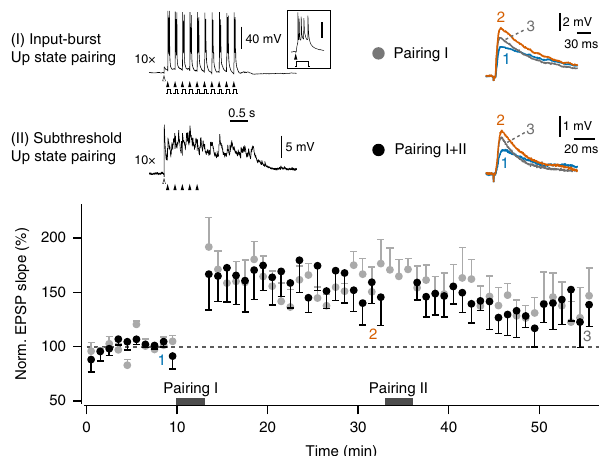
Fig. 2 Pairing subthreshold inputs with Up states does not reverse synaptic potentiation. Pairing synaptic input with spike bursts during Up states induced synaptic potentiation (Pairing I: stimulus trains at 5 Hz, 100 pairings in total; each extracellular stimulation was followed by a depolarizing current step evoking > 3 postsynaptic spikes). In one group of experiments, synaptic responses were measured for > 40 min after input- burst pairing, and in the second group an additional subthreshold Up state pairing (Pairing II: stimulus trains at 5 Hz, 50 pairings in total; same as applied in Fig. 1d) was applied 20 min after input-burst pairing. Top , left : representative recordings during Pairing I ( upper ) and Pairing II ( lower ), showing the timings of Up state induction ( white arrowheads ), synaptic stimulation ( black arrowheads ), and the brief somatic current injections used to evoke spike bursts ( grey steps ). The inset shows one magni fi ed input- burst pairing ( scale bar : 40 mV). Top , right : EPSPs from the baseline (1), 20 min after Pairing I (2) and > 40 min after Pairing I (3), for an experiment with Pairing I only ( upper ) and Pairing I + II ( lower ; average of fi ve traces each). Bottom : pooled data of normalized single EPSP slope across experiments for each pairing protocol (1 min bins), showing a decrease in synaptic potentiation over time, but no signi fi cant effect of pairing paradigm or signi fi cant interaction between time and pairing paradigm (results of mixed measures ANOVA reported in text). Error bars show the